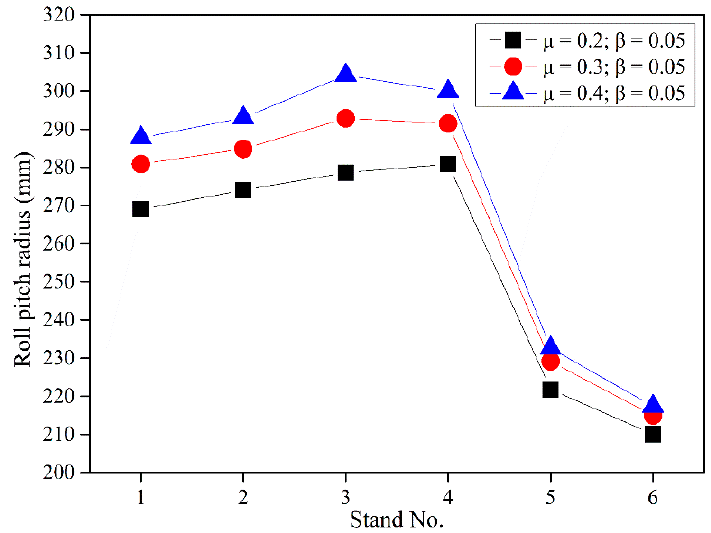
Figure 12. Calculated roll pitch radius with various tube-roll frictional coefficients.